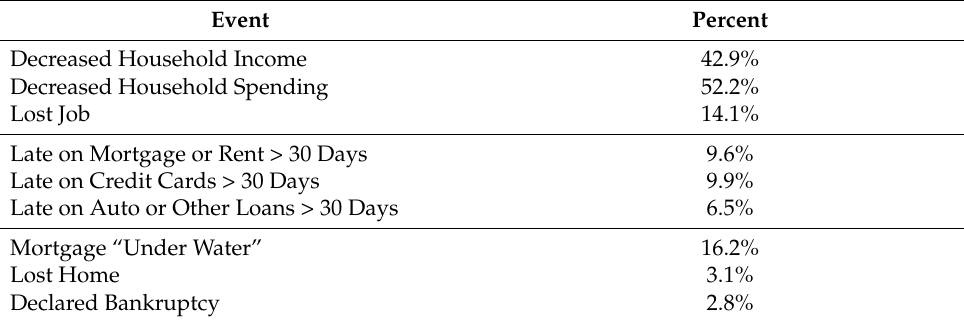
Table 1. The Financial Crisis: Effects on Surveyed Households.